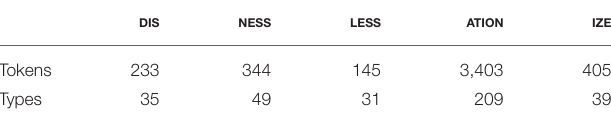
TABLE 1 | Overview of tokens and types per morphological